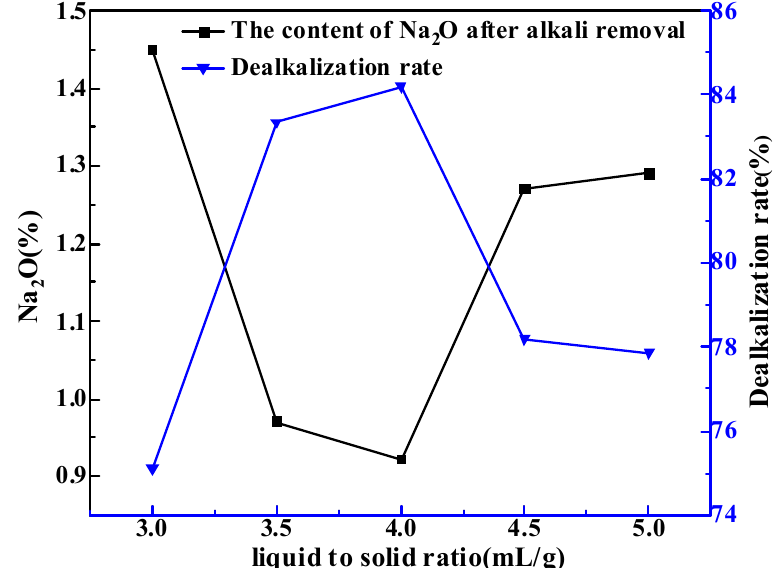
Figure 13. Effect of liquid to solid ratio on dealkalization rate.